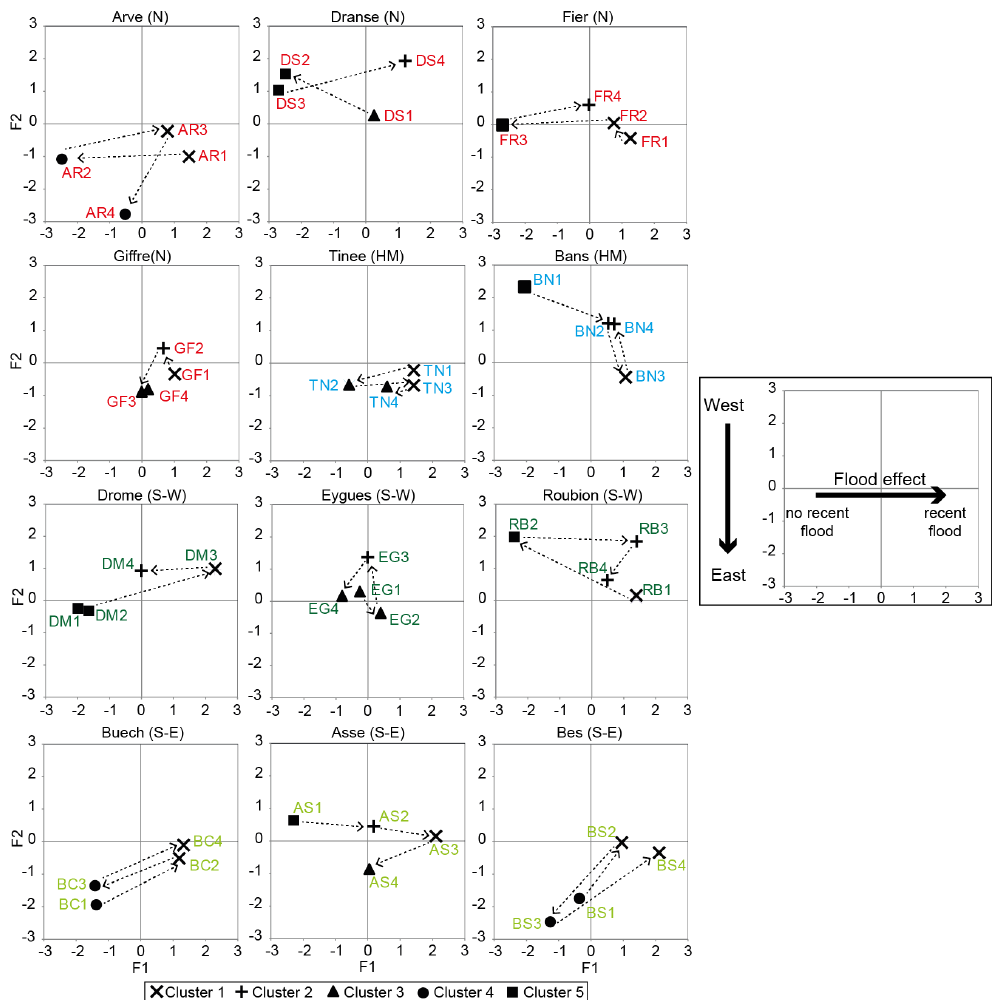
Fig. 6. Temporal trajectory of each reach on the first factorial map. The figure is derived from the first factorial map of Fig. 4b, displaying how each reach is positioned in regard to the first two components and across time; each item is a reach at a given observation date (i.e. reach1, reach2, reach3 and reach4; the chronology of observations goes from 1 to 4). The cluster to which a reach belongs at a given observation date is also indicated, showing how reaches evolve in terms of landscape pattern (see Fig. 5 for cluster characteristics). The physical interpretation of the reach evolution in terms of floods and geographical context is displayed on the right.